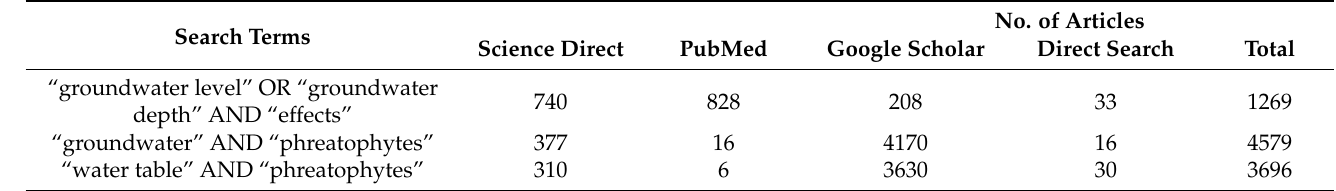
Table 1. The search terms used and their corresponding initial results in ScienceDirect, PubMed, and Google Scholar databases, and direct